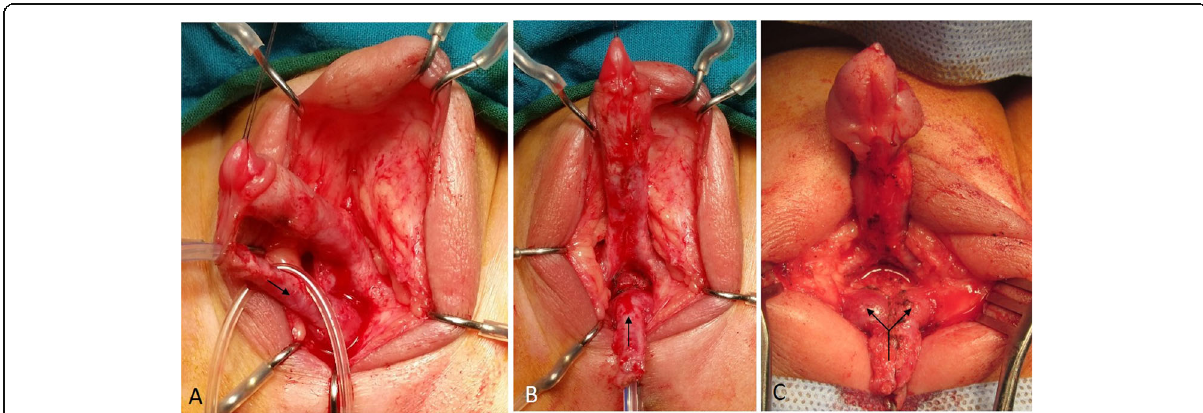
Fig. 2 Feminizing genitoplasty (cont.). Separation of the urogenital sinus (arrow) together with the surrounding ventral erectile tissue from the dorsal corporeal bodies of the genital tubercle. a , b First case 8-month-old girl with CAH. c Second case 10-month-old girl with CAH. Note the divergence of the bulbus spongiosum in c compared to that in b